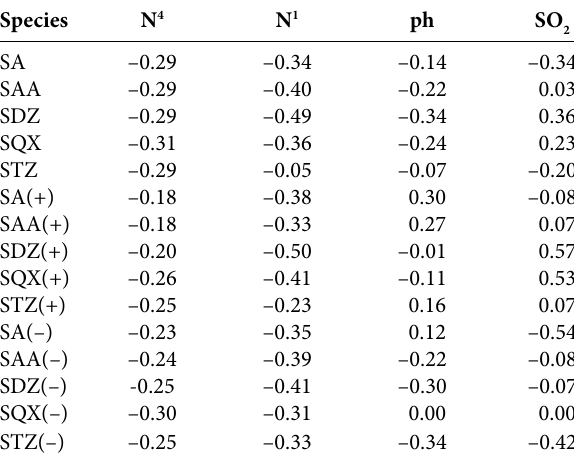
Table 3. Some atomic and group charge distributions of SAs in neu- tral and both radical cation (+) and radical anion ( – ) states. Species N 4 N 1 ph SO